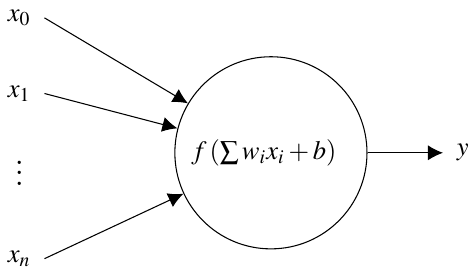
Figure 7. Schematic representation of a neuron , the building block of multi-layer perceptrons. It takes a vector as input and generates a scalar output by applying the function to the dot product of the input and the weights plus the bias